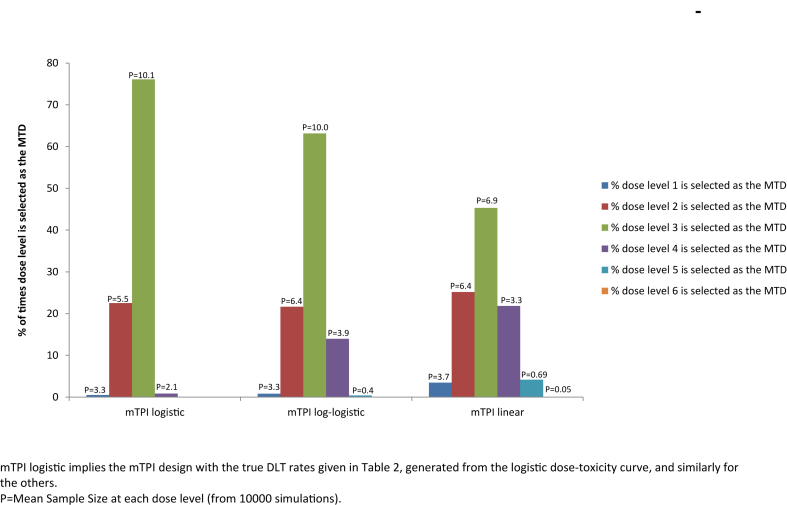
The depicts the percentage of times that the mTPI design selects each dose level as the MTD for the true DLT rates given in Table 2, generated from the three dose-toxicity curves. These percentages are from simulations and the results are shown in Table 3, Table 4, Table 5.